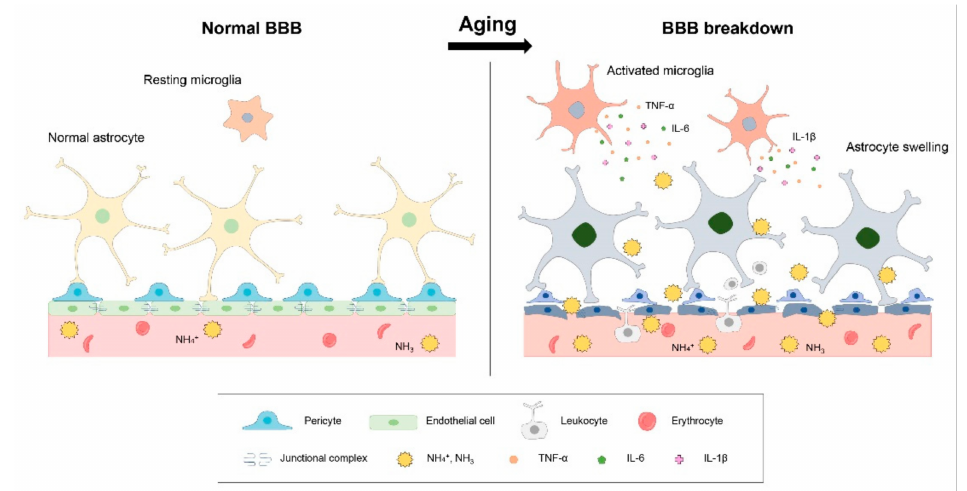
Figure 1. BBB breakdown and neuroinflammation in aged